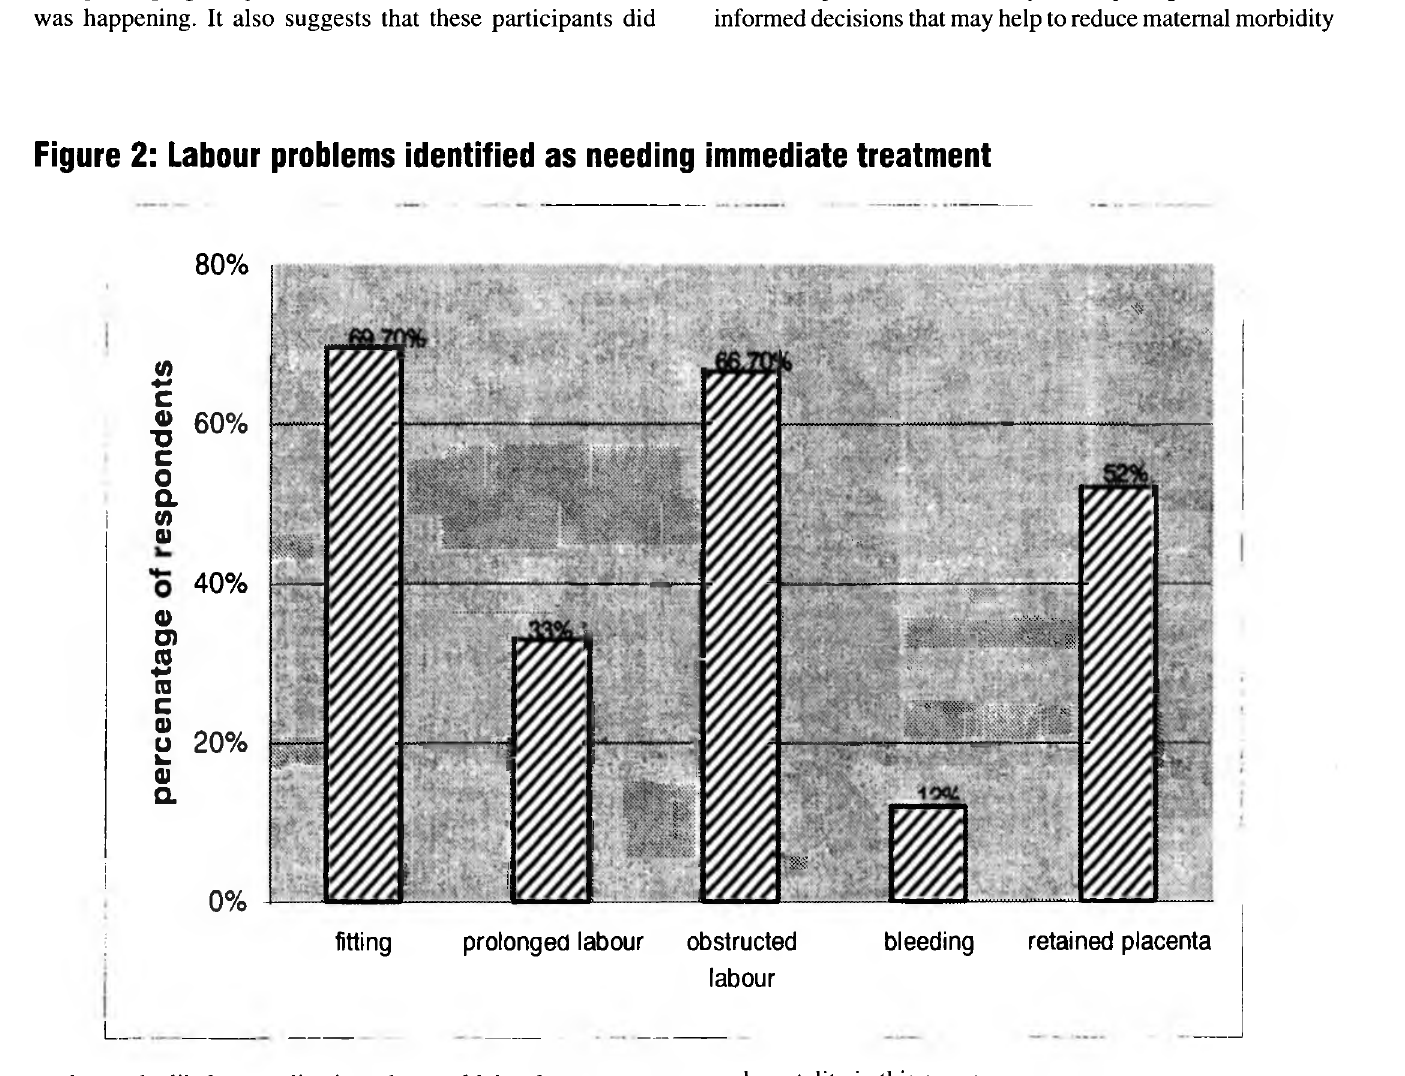
Figure 2: Labour problems identified as needing immediate